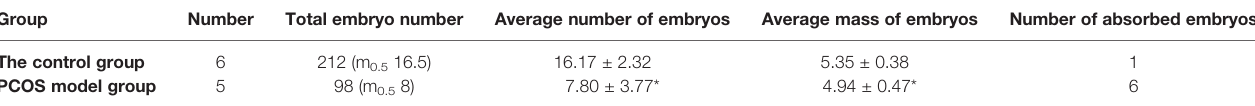
TABLE 3 | The embryo outcomes of rats on GD 18.5.